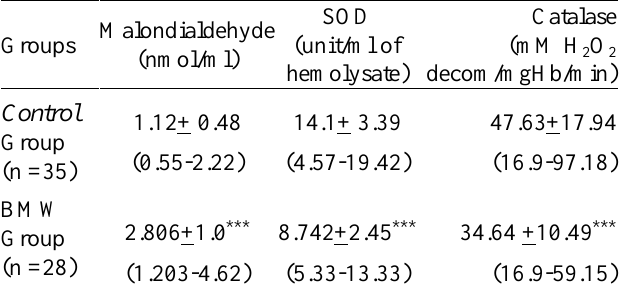
Table 3 : Lipid peroxide (MDA), superoxide dismutase (SOD) and catalase activities in battery manufacturing workers and control